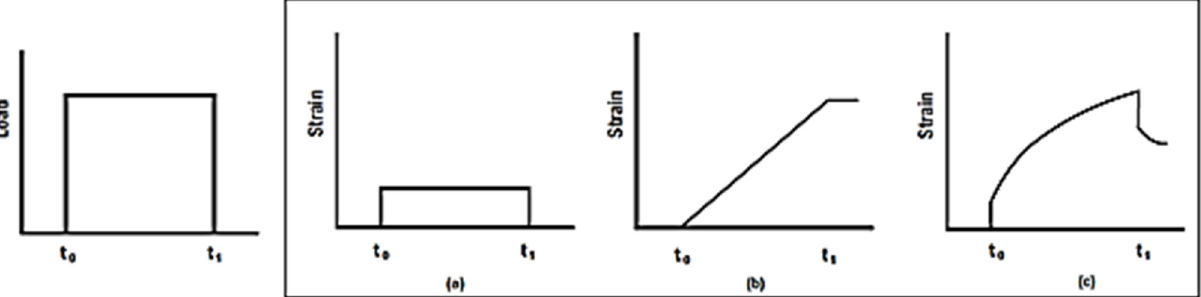
Figure 25. Different strain responses to a constant load: ( a ) Hook’s law (instantaneous elastic deformation); ( b ) viscous behavior (deformation is delayed); and ( c ) real elastic recovery (time-dependent